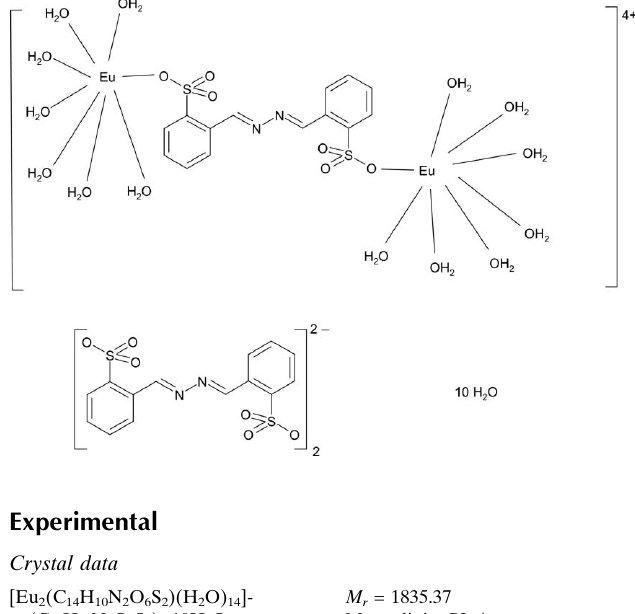
Related literature